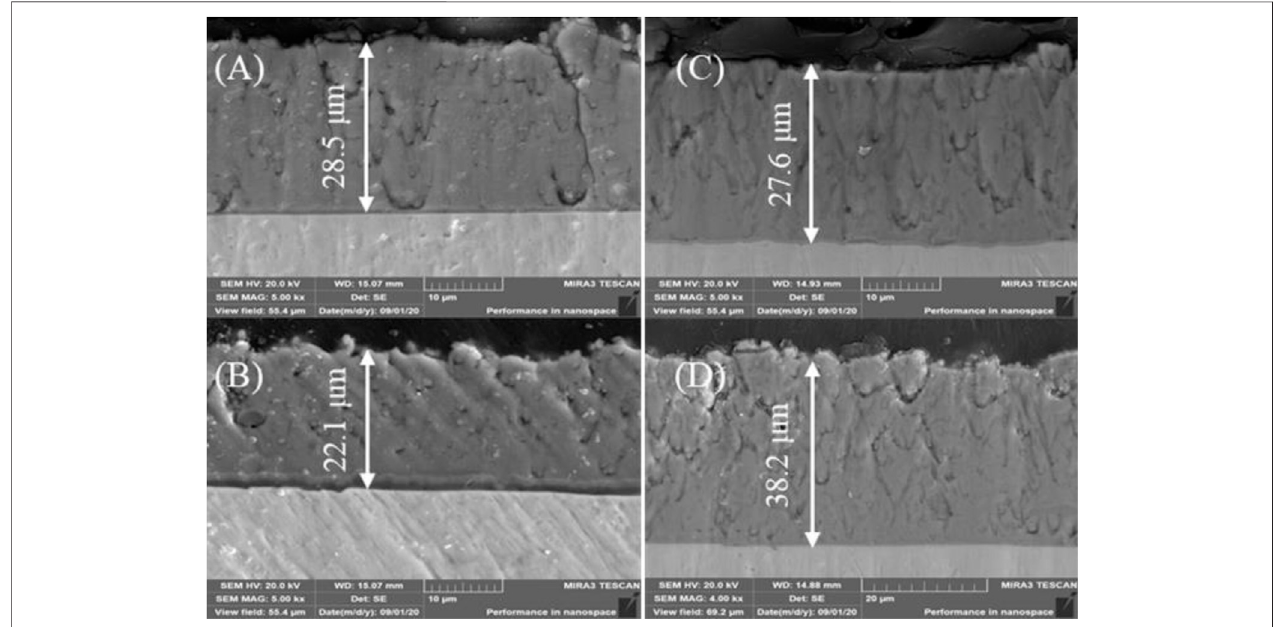
FIGURE8| Cross-sectionalSEMimagesofeachATFcandidatecladding(depositiontime:6 h), (A) uppersideand (B) lowersideofCr 32.1 Al 67.9 , (C) uppersideand (D) lower sides of Cr 45.8 Al 54.2 .